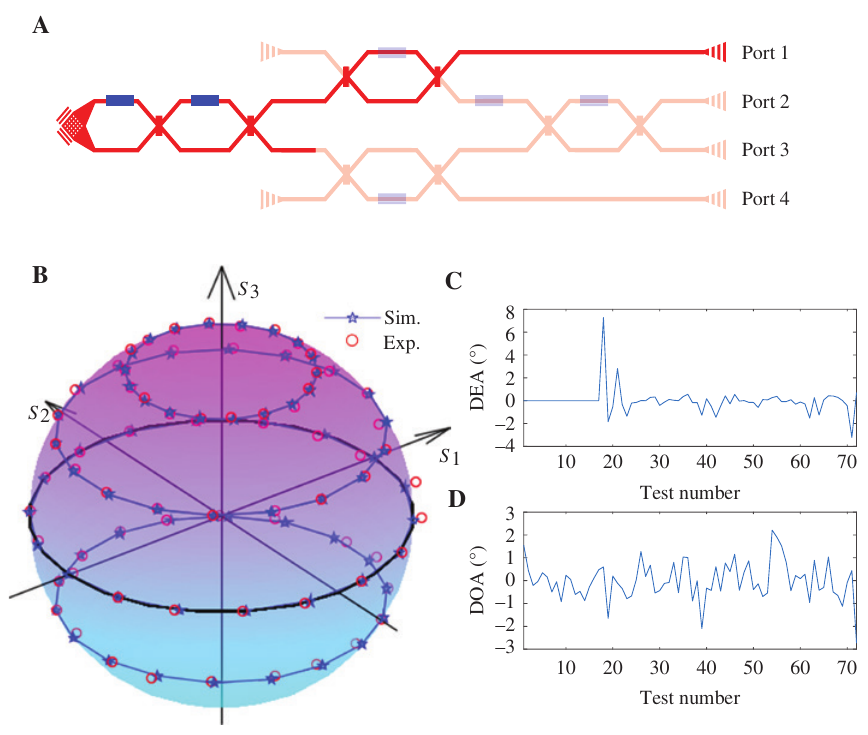
Figure 7: Experimental results for a division-of-time polarization analyzer. (A) Used structure. (B) Experimental Stokes parameters compared with the theoretical results. (C) Deviations of the ellipticity angle. (D) Deviations of the orientation angle.